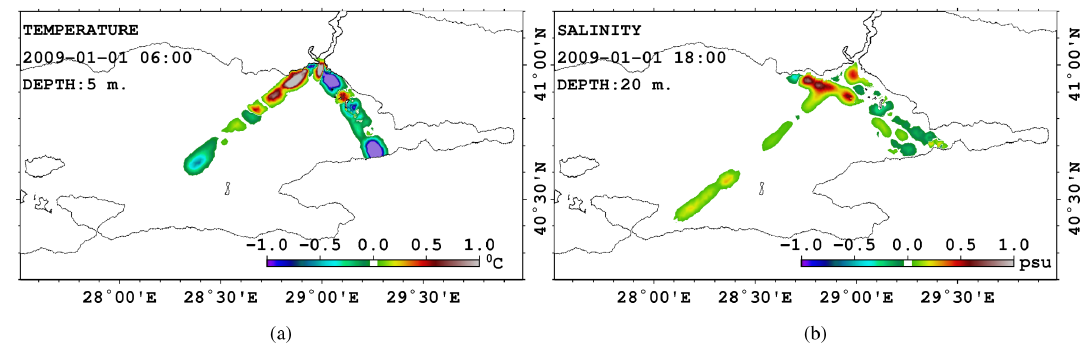
Figure 7. Mean increments after assimilation for (a) temperature at 1 January 2009 at 06:00UTC at 5m depth and (b) salinity at 1 January 2009 18:00UTC at 20m